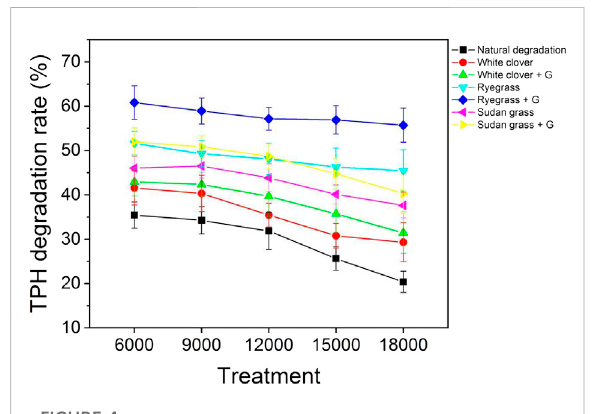
FIGURE 4 Degradation rate of total petroleum hydrocarbons in soil under blank control, plants, and plants with glycine